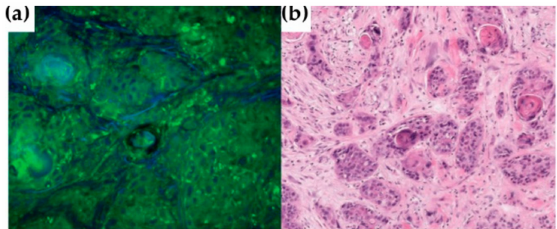
Figure 8. ( a ) CRS microscopy image generated through the contrast between CH2 and CH3 stretching vibrations at 2845 cm − 1 and 2940 cm − 1 , respectively, demonstrating hypercellu-larity and atypical nuclei, obtained by Hoesli et al. [121] and ( b ) Corresponding H&E stained specimen